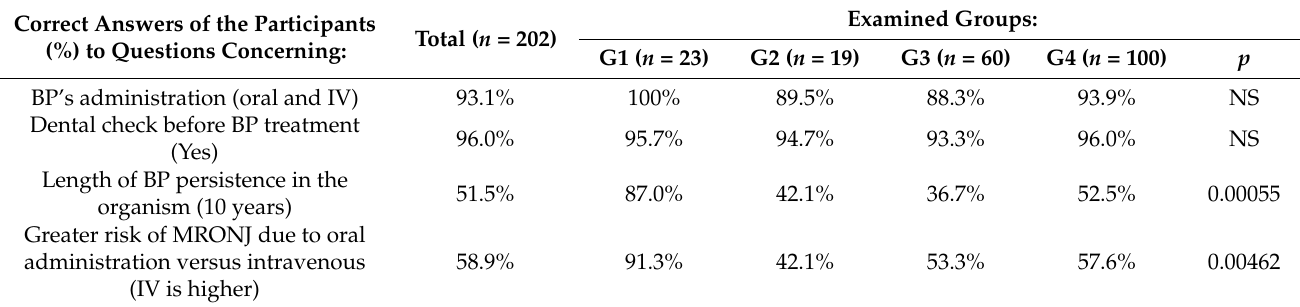
Table 3. General knowledge about bisphosphonates.